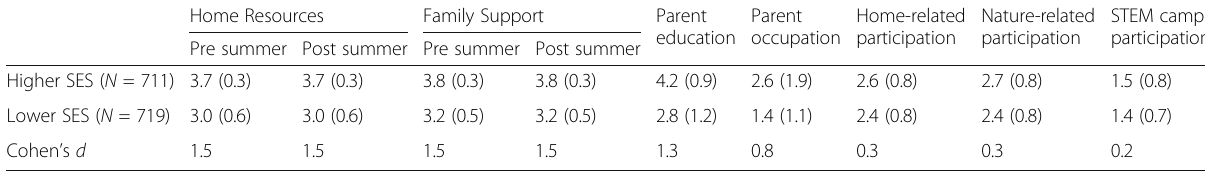
Table 4 Means and standard deviations for the home resources, family support, parent education, parent occupation, and optional summer science experiences surveys for the higher SES and lower SES groups, and Cohen ’ s d for the differences between